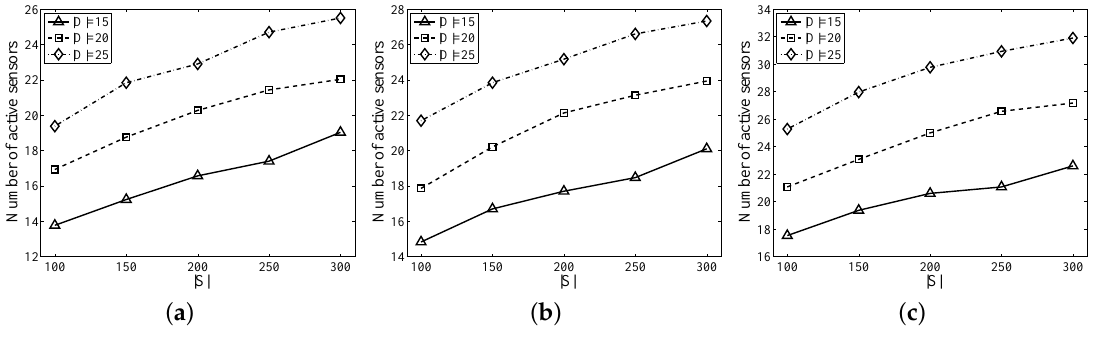
Figure 7. Performance of the minimum vertices maximum flow algorithm (MVMFA) with different | S | and | D | . ( a ) (cid:101) = 0.7; ( b ) (cid:101) = 0.8; ( c ) (cid:101) = 0.9.